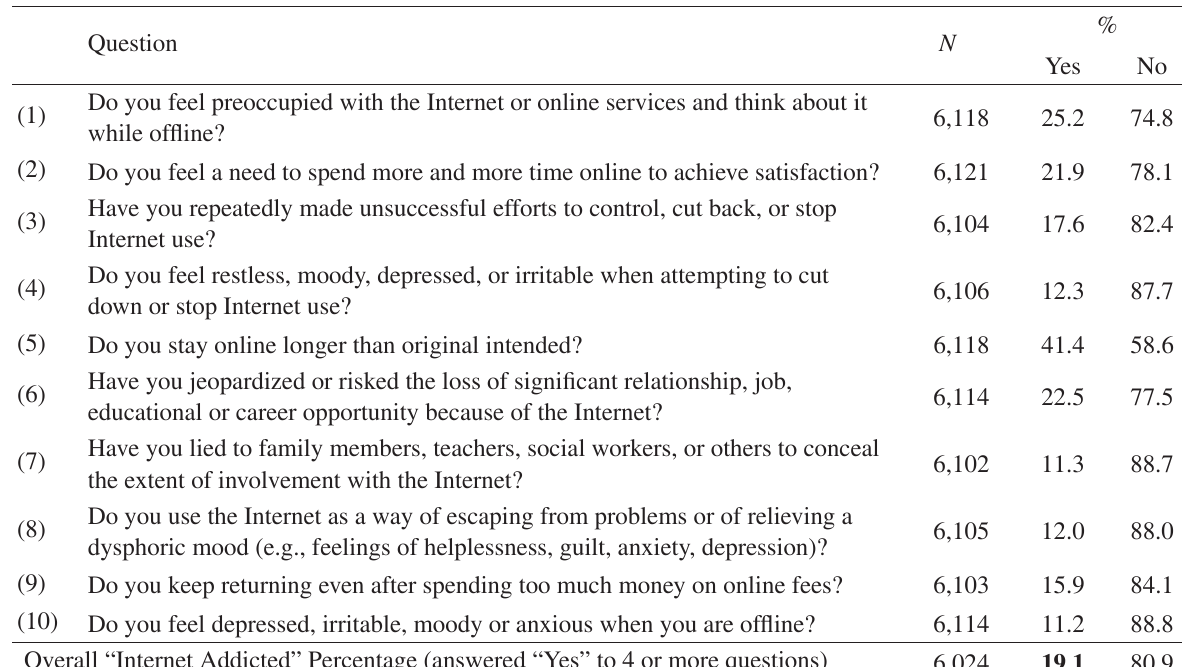
TABLE 7: Percentages of responses to the questions in CIA-Young